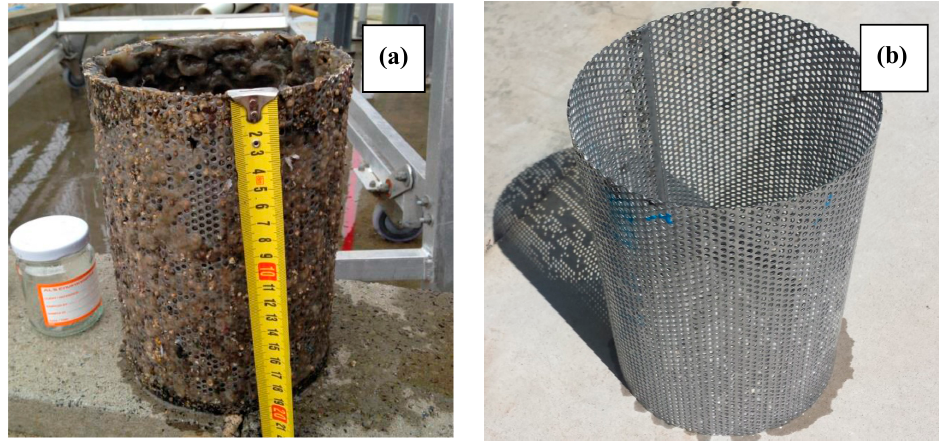
Figure 4. Appearance of the basket strainer 4 months after commissioning ( a ), and after cleaning immediately before performance of clean in place (CIP) procedures ( b ).